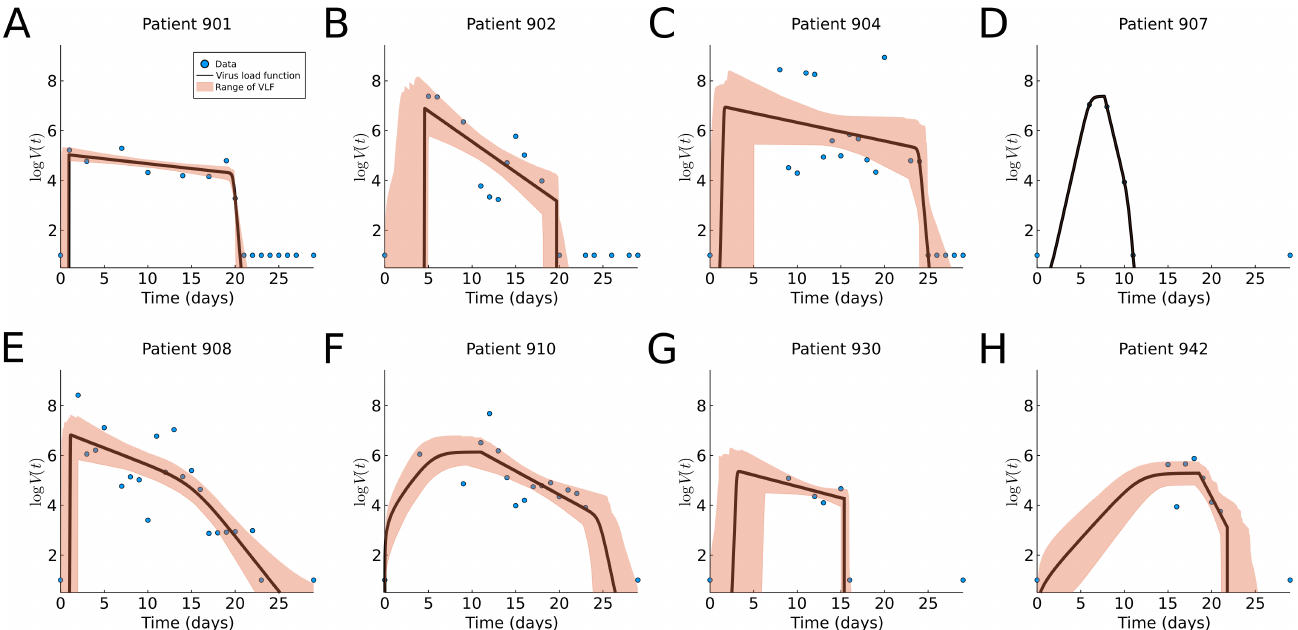
Figure 7. Fitting results of the virus load function (1) to human SARS-CoV-2 data [5]. The blue dots represent the individual measurements and the black line is our best fit. The area in red represents the likelihood range of virus load functions. ( A – H ) Fitting to patients 901, 902, 904, 907, 908, 910, 930, and 942, respectively. The black curve is the nonlinear square fit, and the shaded region indicates virus load curves with RSS within relative tolerance (cid:101) =